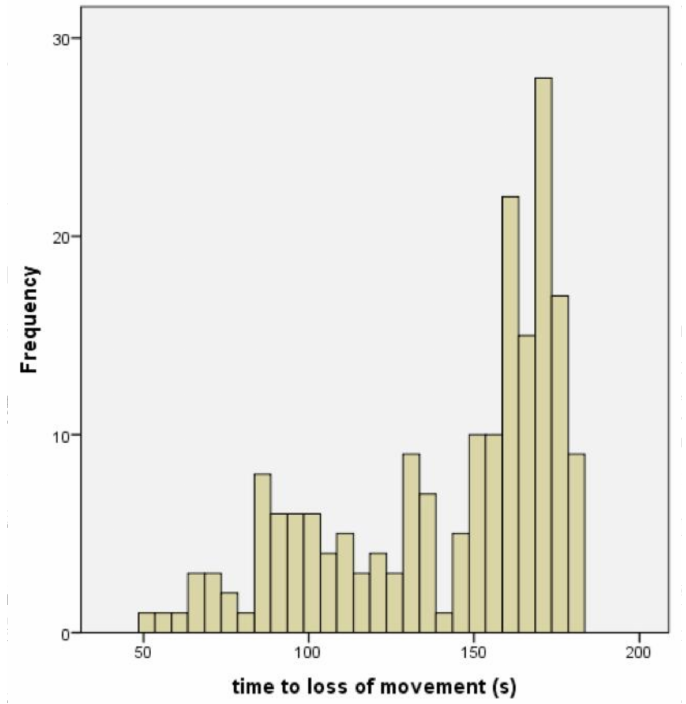
Figure 5. The distribution of time to loss of movement in lambs post-shot (mean = 141.79, SD = 34.084, n =